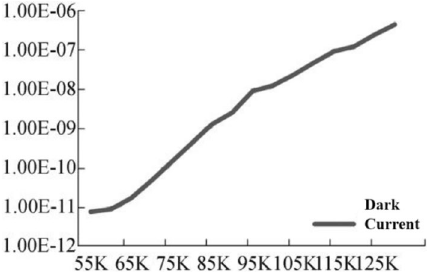
Figure 5. Relationship of dark current and operating temperature of HgCdT 7